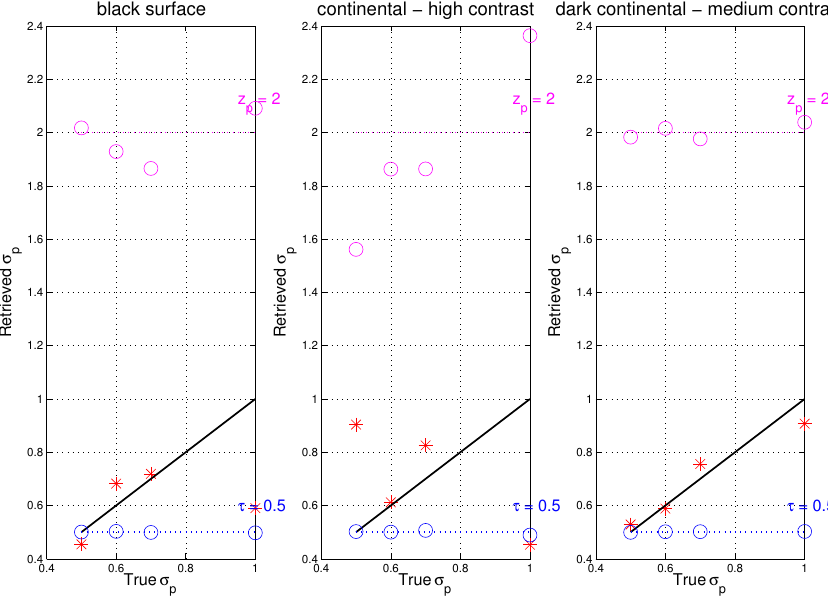
Fig. 7. Synthetic retrievals of the peak width of a lognormal aerosol vertical profile σ p (red asterisks), aerosol optical thickness τ aerosol (blue circles) and peak height z p (magenta circles), for varying σ p and fixed parameters τ aerosol =0.5 (blue dashed line) and z p =2km (magenta dashed line). The black line is the 1:1 line. A coarse urban absorbing aerosol (IA3) has been used. The viewing geometry is statistically representative for SCIAMACHY observations over Kanpur with SZA=43 ◦ , LZA=11 ◦ , Azimuth=149 ◦ . Left panel: black surface, ρ A = ρ B =0, middle anel: land surface having high contrast, ρ A =0.22, ρ B =0.03, right panel: dark land surface having medium contrast, ρ A =0.13, ρ B